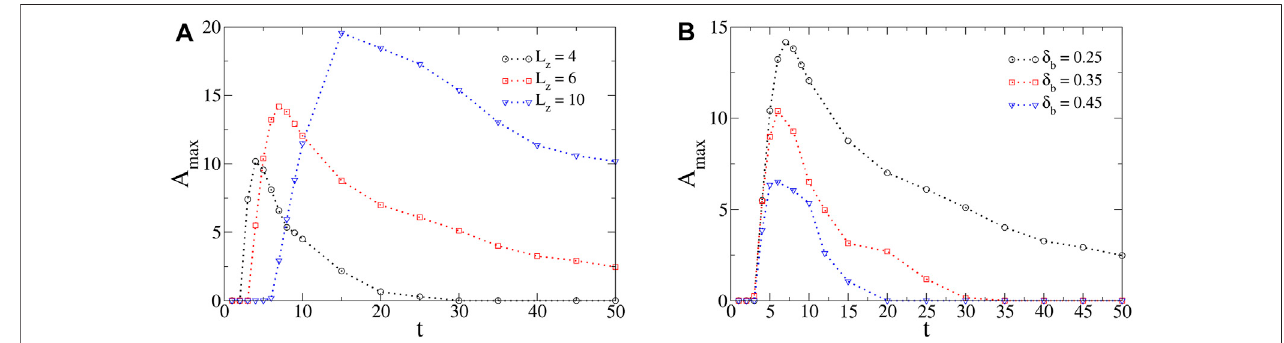
FIGURE6 | Maximum amplitude A max ofoscillations in the course oftime for differentvalues of (A) L z and (B) δ b . Unless varied, the values ofthemodel parameters are M = 250, M c = 500, δ b = 0.25, δ c = 0.50, β = 2 and L z = 6. When increasing L z or decreasing δ b , the maximum amplitude and duration of oscillations in the pro fi les of surface tension are